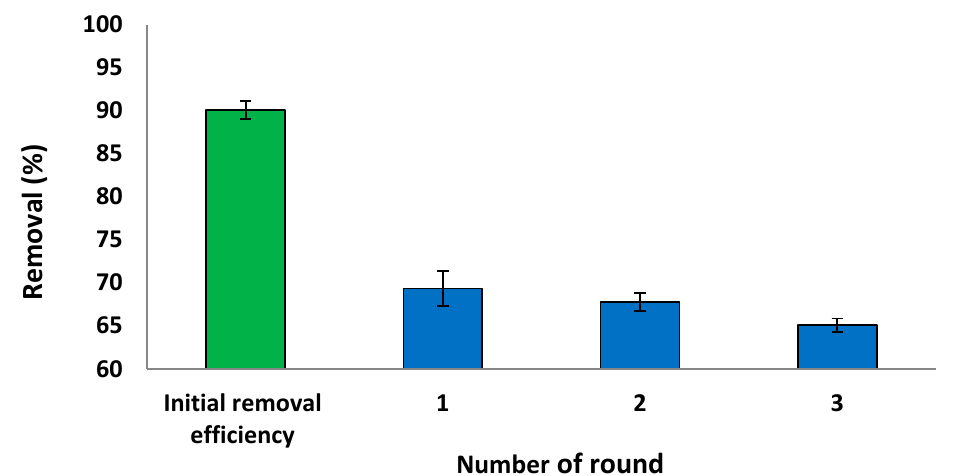
Figure 19. Reusability study of the S. costatum after adsorption of CVD.